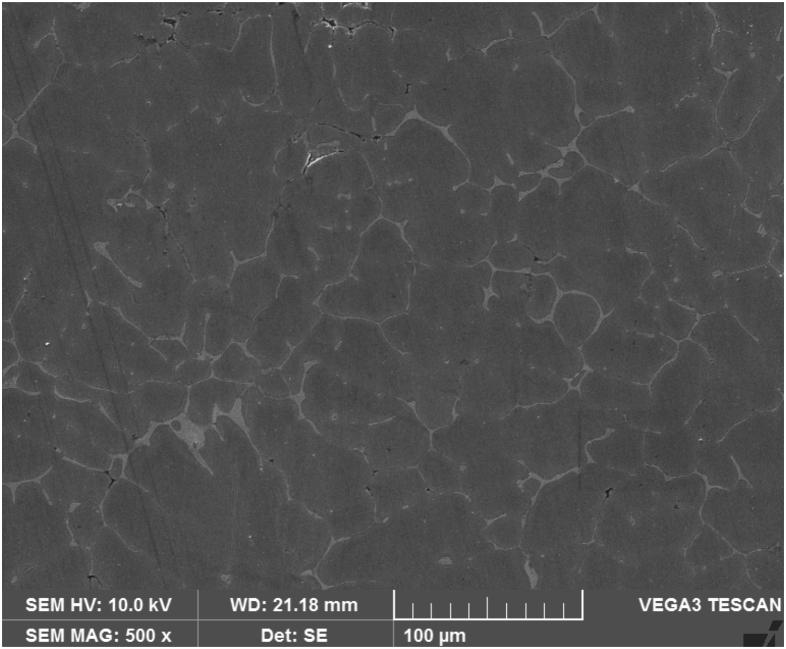
Al–Si base alloy.